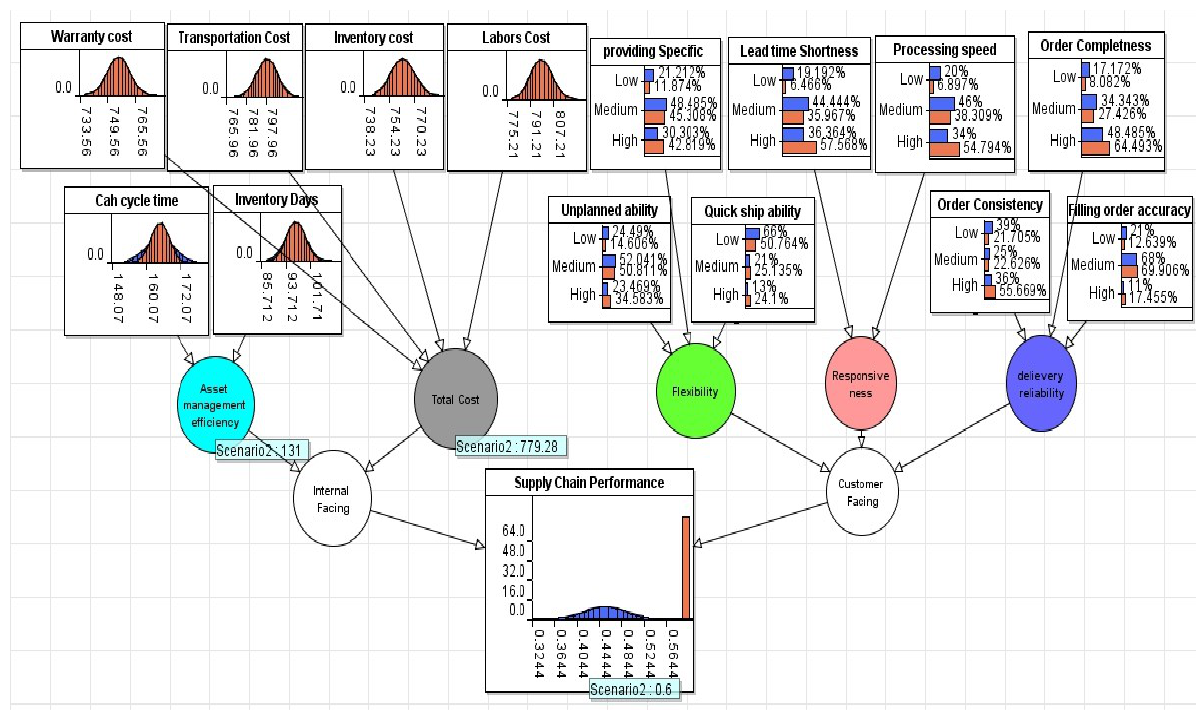
Figure 3. Model statue while running scenario 2